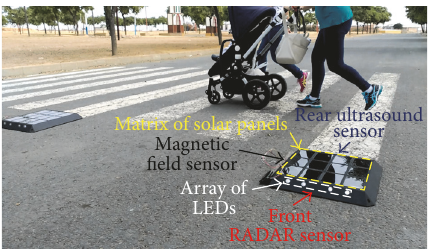
Figure 4: Example of the prototype developed on the